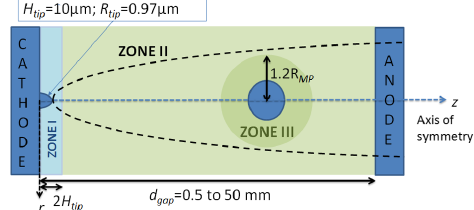
FIG. 1. Sketch showing the phenomena occurring in the interelectrode gap. Both the tip (on the cathode) and the micro- particle (MP) are at micrometer ( μ m) scale, while the anode- cathode gap is in the mm range (the figure is not to scale). The dashed lines denote the trajectories of thermofield emitted electrons from the tip due to the high anode-cathode voltage.